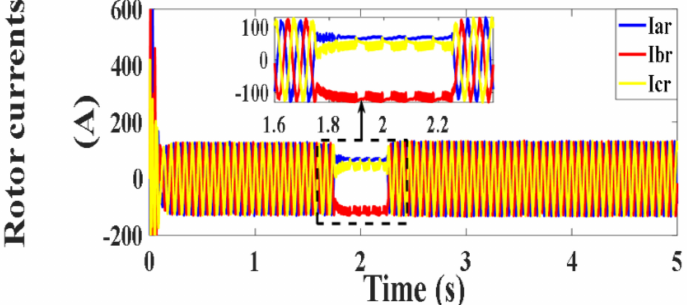
Figure 57. Rotor currents under PVC (A).